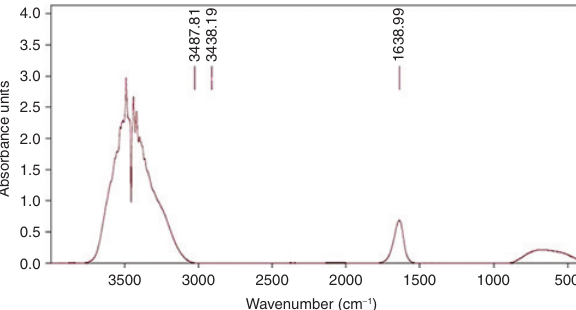
Figure 1: FT-IR spectra of A. fumigatus mycelia